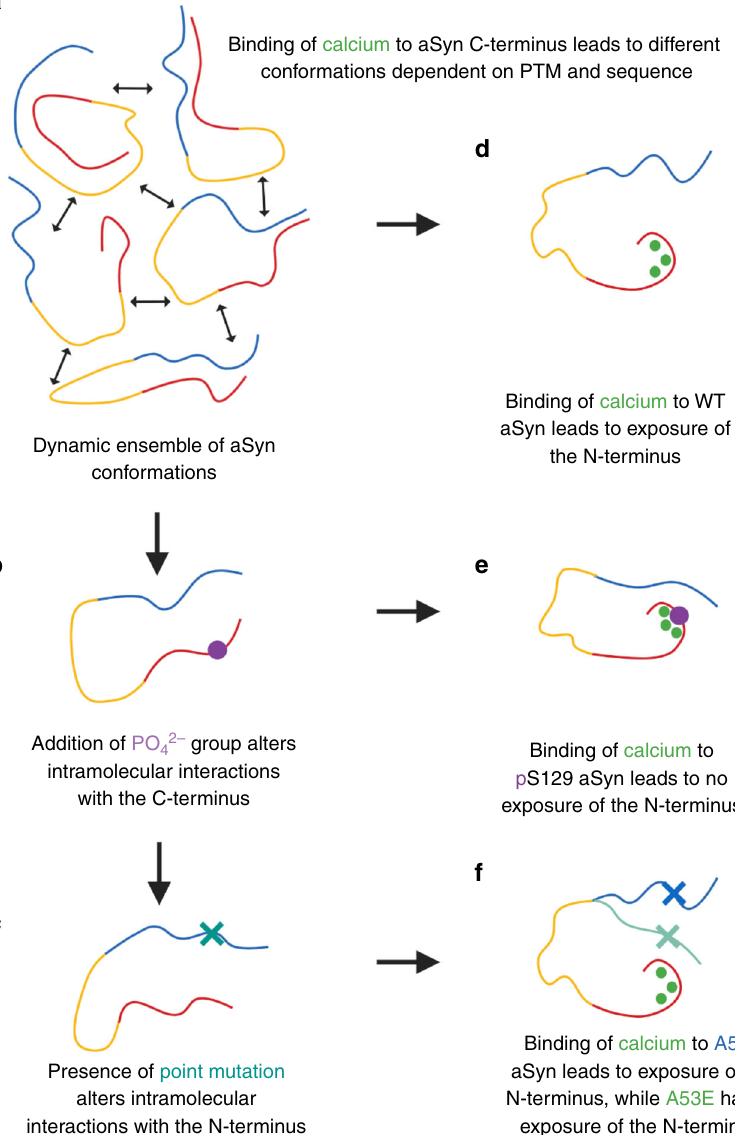
Fig. 7 Cartoon representation of the effect of phosphorylation, mutation and calcium binding on aSyn. a aSyn is a dynamic ensemble of conformations in solution. Its solubility is maintained by long-range interactions between the N-terminus (blue), NAC region (yellow) and the C-terminus (blue) of aSyn. b Addition of a phosphate group to S129 (purple circle) or c a point mutation (teal cross) alters the long-range interactions and skews the dynamic ensemble to favour or disfavour aggregation prone structures. d Addition of divalent cations such as calcium (green) leads to charge shielding and exposure of the N-terminus of aSyn. e Calcium binding to phosphorylated aSyn leads to different perturbations of long-range interactions. Phosphorylation at S129 leads to a slightly different calcium binding region and to reduced solvent exposure of the N-terminus compared to WT aSyn. f The aSyn mutation A53T (blue with blue cross) leads to N-terminus solvent exposure upon calcium binding at the C-terminus, similar to WT aSyn, however, the aSyn mutation A53E (light teal with teal cross) leads to less N-terminus solvent exposure upon calcium binding. Created with